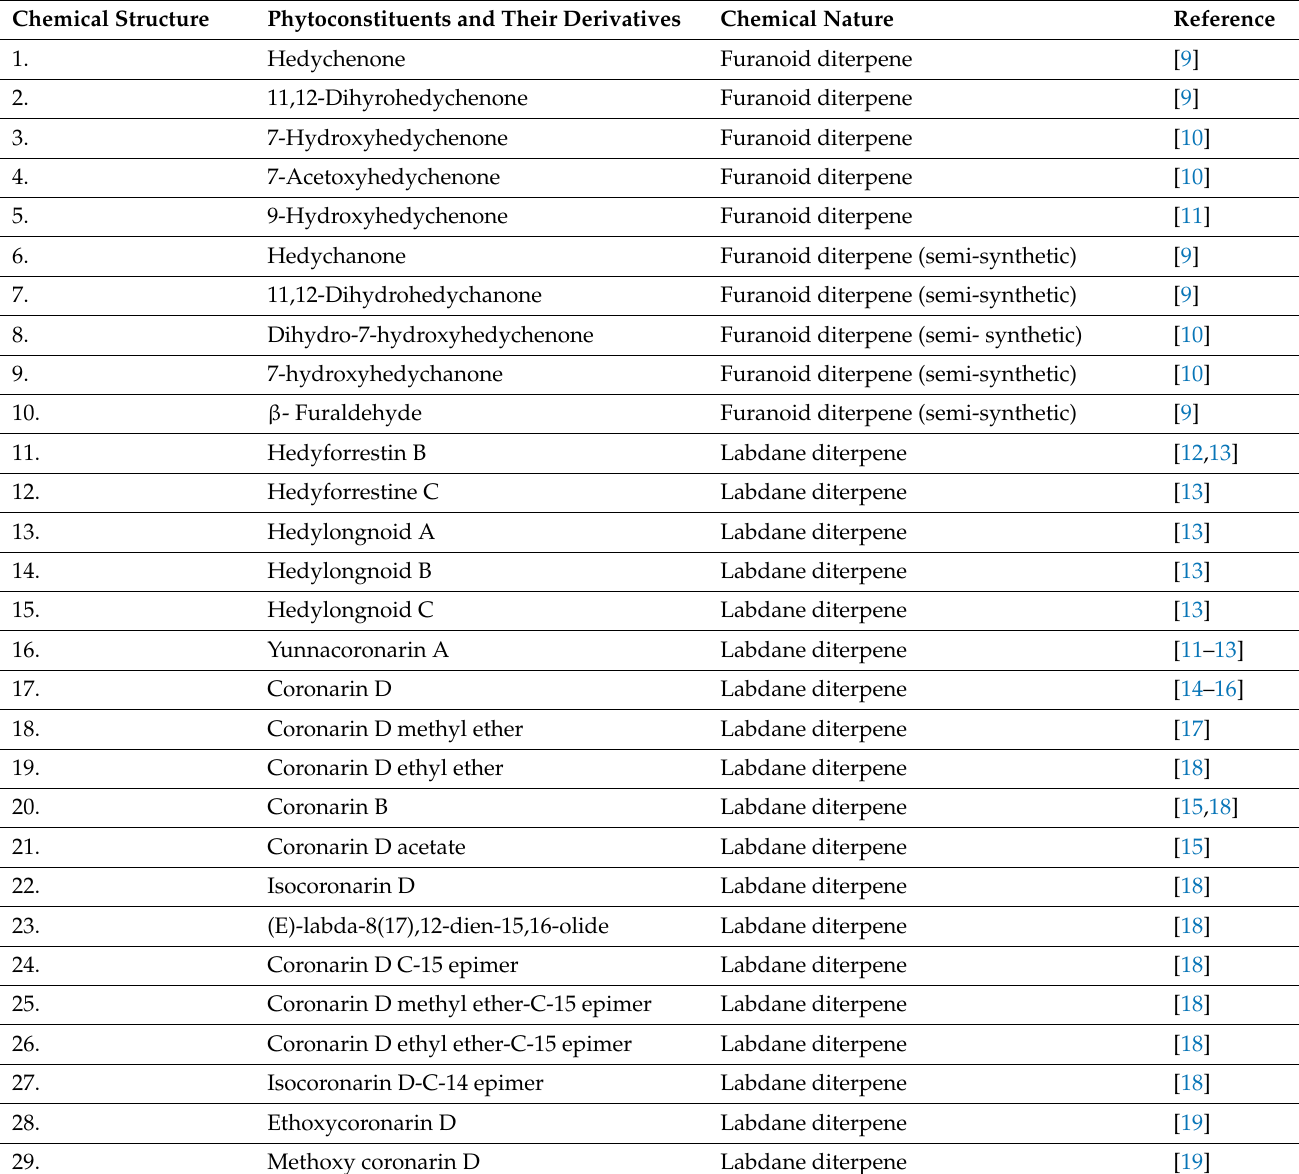
Table 1. Phytoconstituents and their semisynthetic derivatives from Hedychium species . Chemical